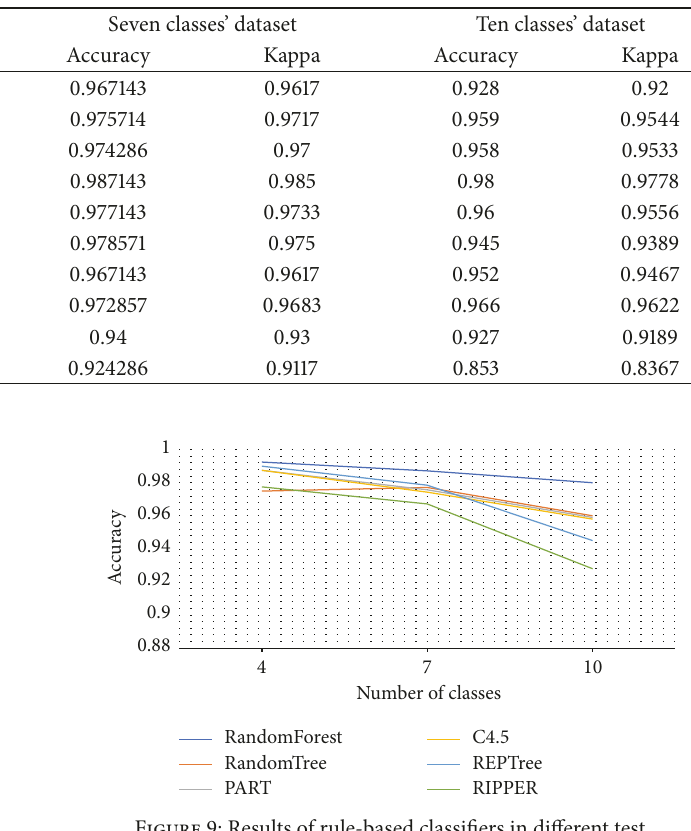
Figure 9: Results of rule-based classifiers in different test. Table 3: ROC analysis of the best